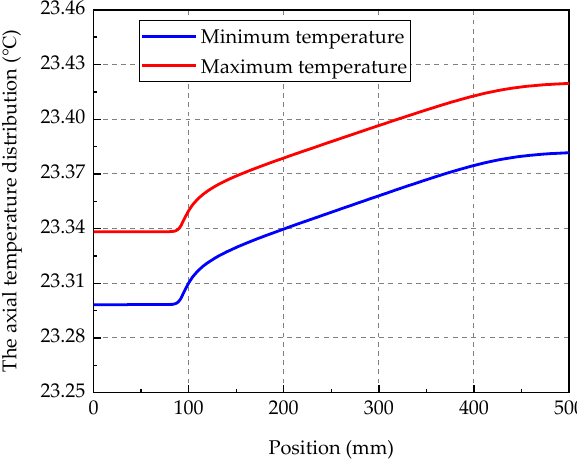
Figure 6. Temperature distribution on the central axis of the atomic flight